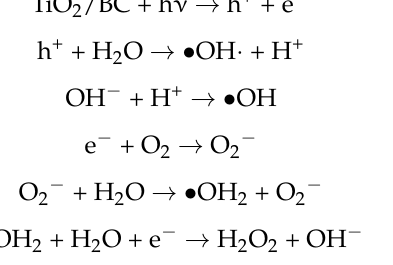
Table 1. Photocatalytic degradation of Sulfamethoxazole (SMX) at different experimental conditions using biochar- supported TiO 2 nanocomposite and other hybrid TiO 2 composites.